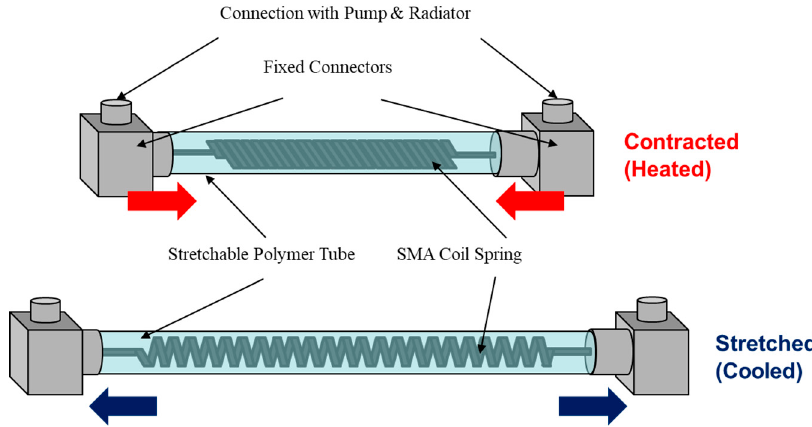
Figure 1. Schematic of the shape memory alloy (SMA)-based actuator.